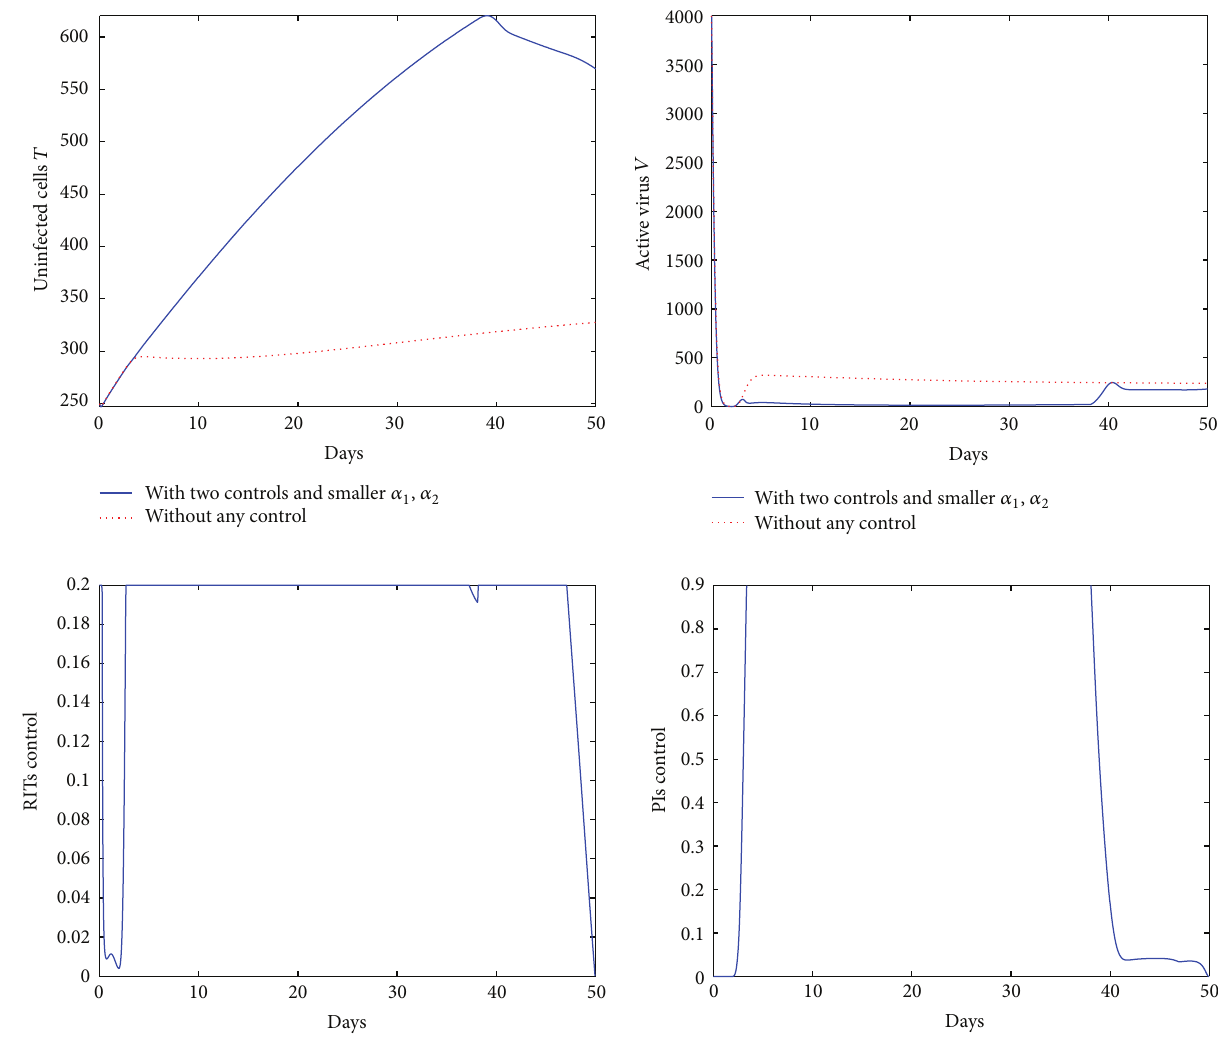
Figure 9: Optimal solutions using RTIs and PIs with sufficiently small 𝛼 1 ≈ 𝛼 2 and bigger upper-bound 𝑏 1 for a 50-day treatment.